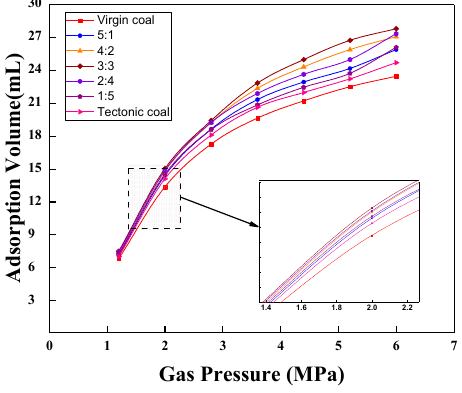
Figure 3. Isothermal adsorption quantity with different mass ratios of mixed coal.